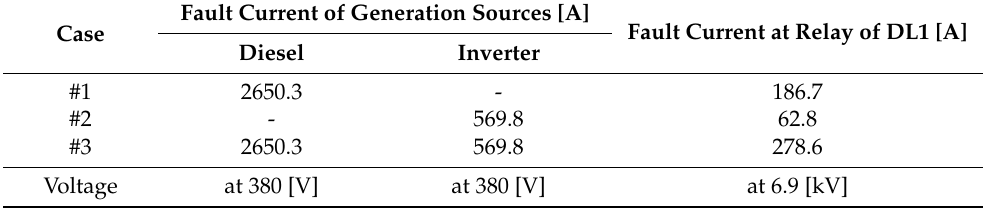
Table 4. Summary of fault current calculation by case.